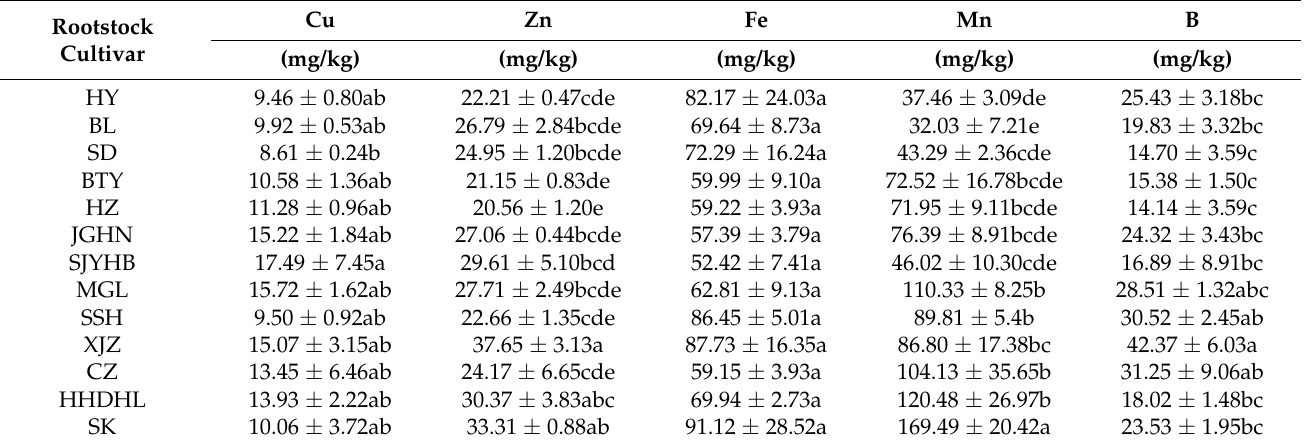
Table 5. Micronutrients in leaves of ‘Lingfengnuo’ grafted onto different